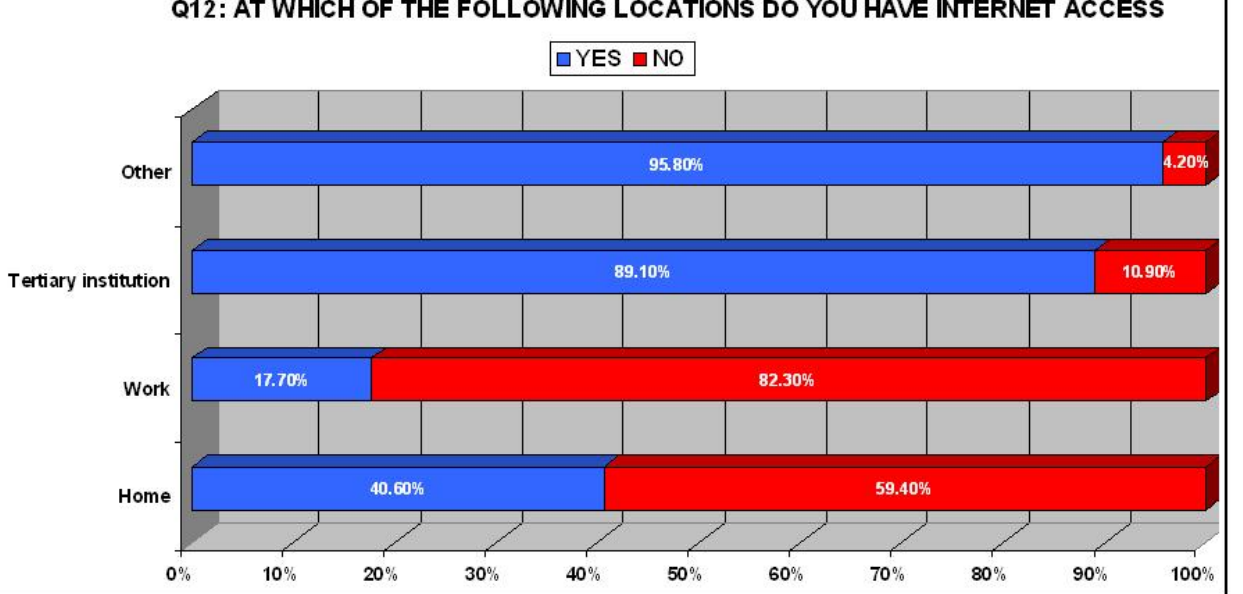
Figure 9 Representation of the responses to Question 12 of the survey